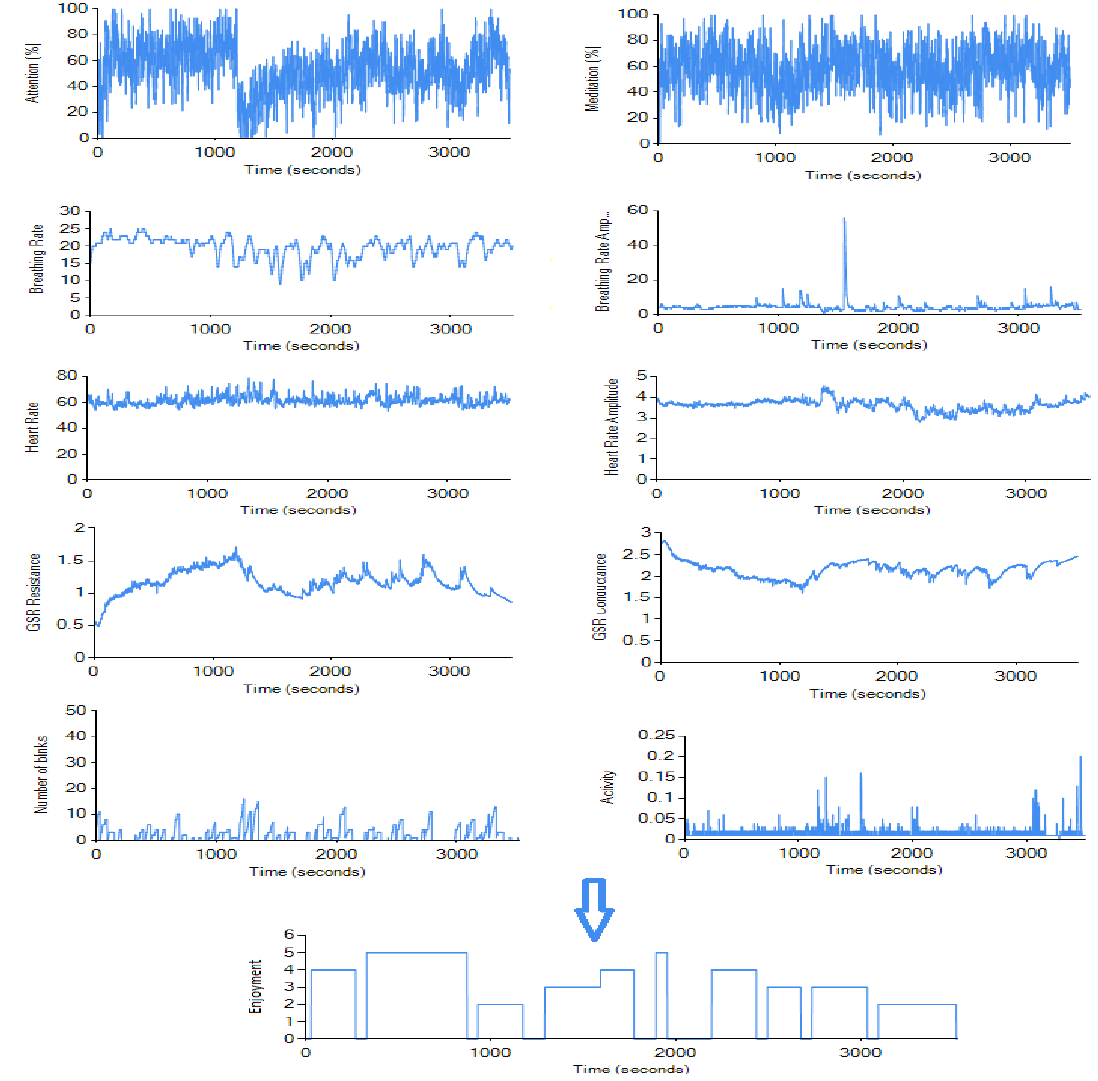
Figure 3. Sample data from our data collection software. Ten features were measured by